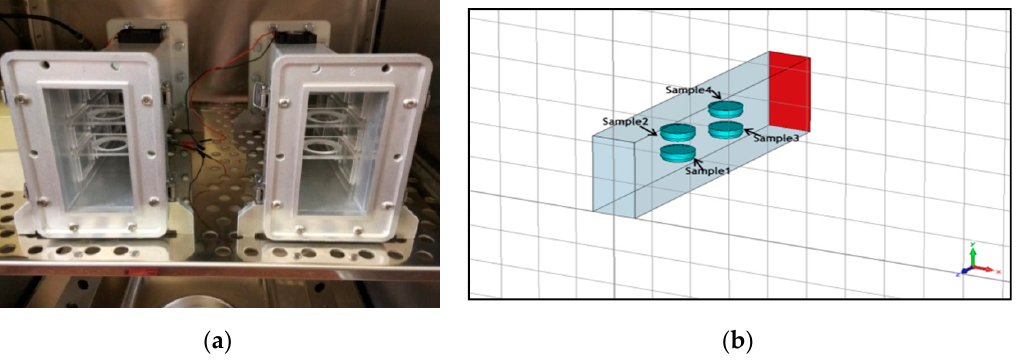
Figure 2. ( a ) Placement of the petridishes in the radiofrequency (RF) waveguide system, and ( b ) modeling for simulation of dosimetry.